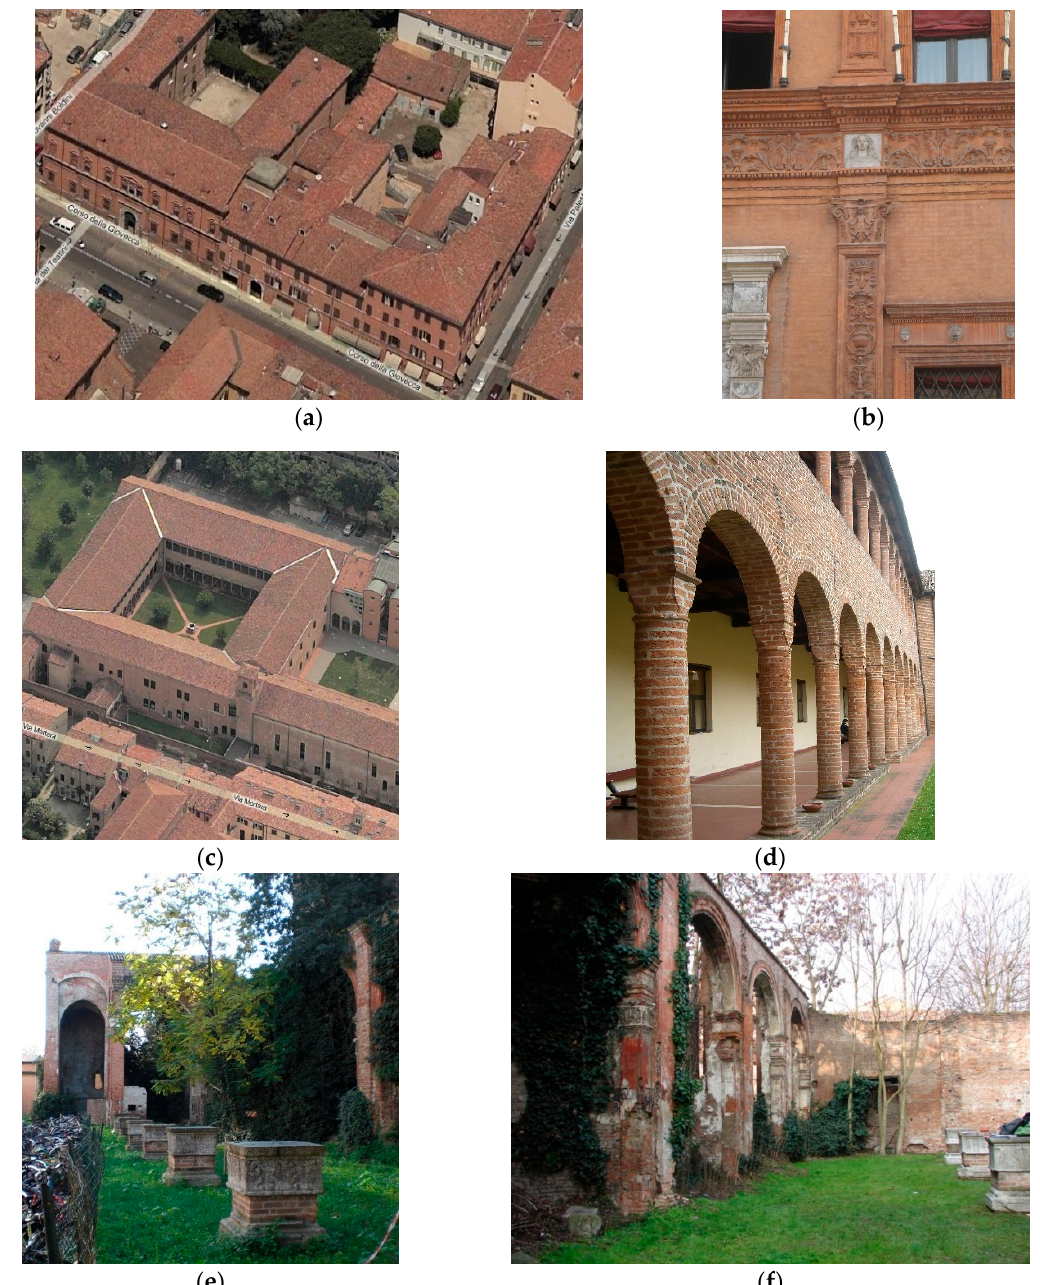
Figure 1. Map of the sampling sites in the city center of Ferrara. Colored in yellow the three different sampling sites: Palazzo Roverella, the cloister of the monastery of Santa Maria delle Grazie and the church of San Andrea. Colored in white the Ferrara castle that represents the main center of Ferrara and colored in light blue other historical buildings (the Cathedral, the church of Santo Stefano, the church of Santa Maria in Vado, the monastery of San Antonio in Polesine and Palazzo Schifanoia) whose XRF analyses were used for comparison.